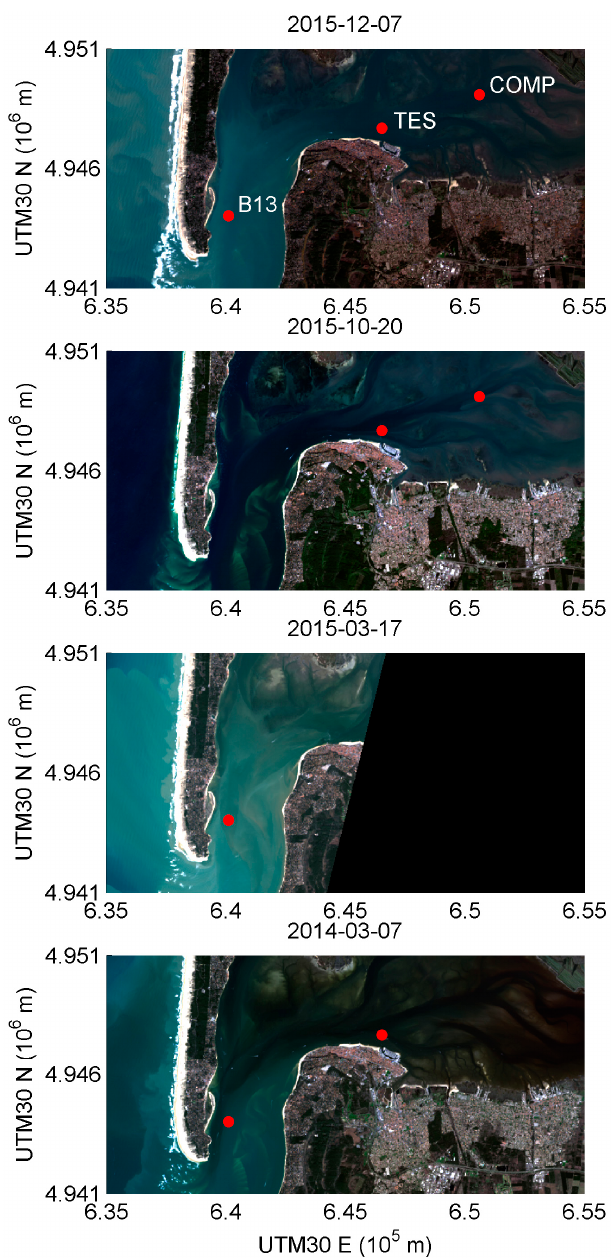
Figure 3. RGB composite (channels 4-3-2) of the four Operational Land Imager (OLI) images associated